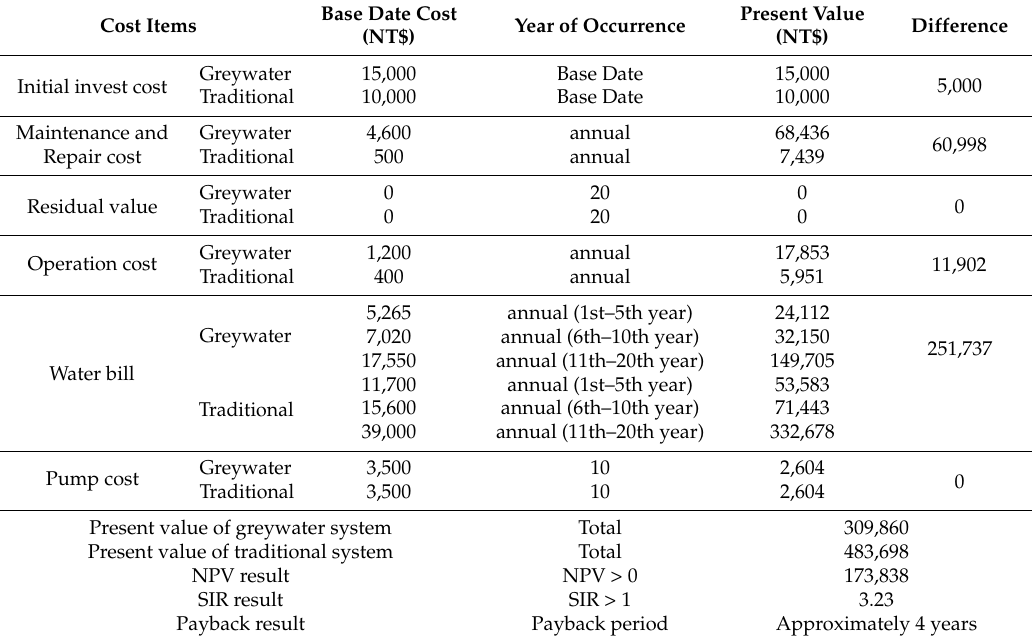
Table 4. Economic analysis of scenario